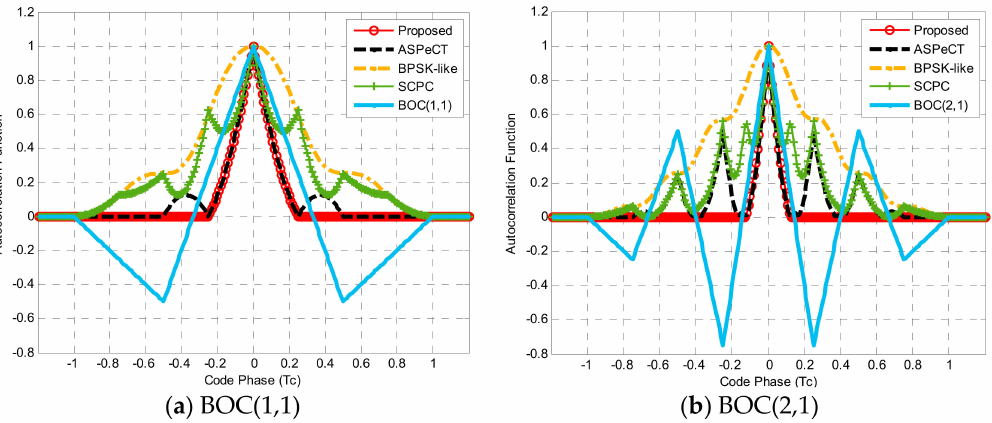
Figure 14. Comparison of the normalized autocorrelation